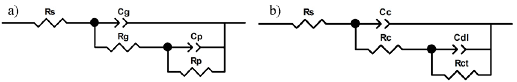
Figure 6. Electrical equivalent circuit proposed for: a) the uncoated Ti-6Al-4V alloy, b) the coated Ti-6Al-4V alloy, in NaOH solution.